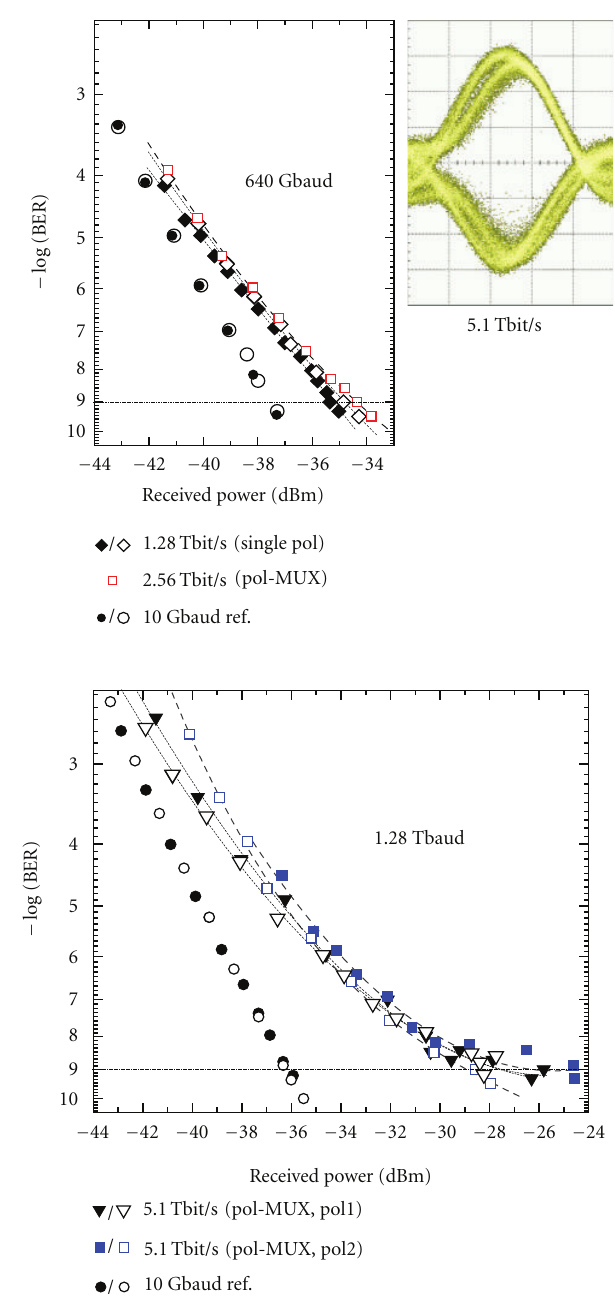
Figure 15: 5.1 Tbit/s demultiplexing and